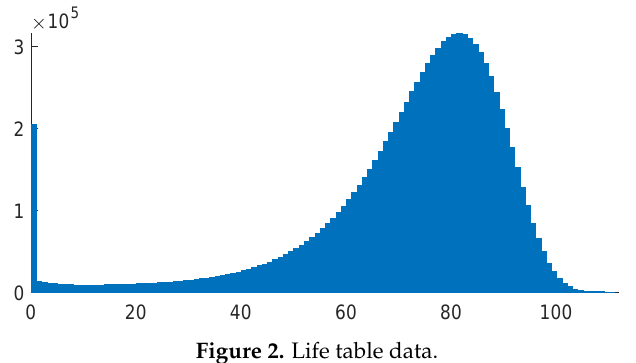
Figure 2. Life table